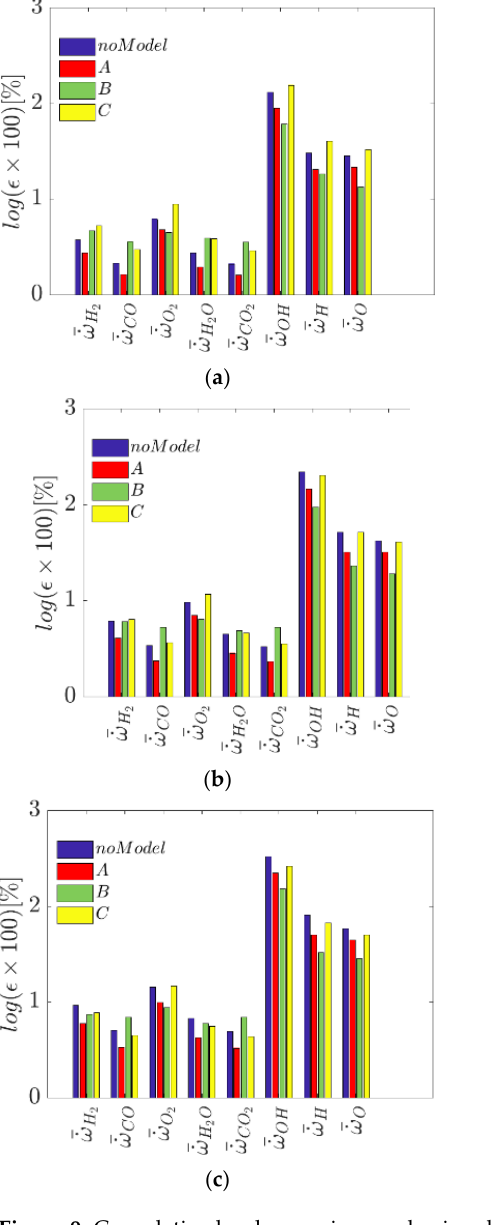
Figure 9. Cumulative local errors incurred using different models in prediction of different species net formation rates: ( a – c ) logarithm of errors for all models; and ( d – f ) the errors are divided by the “no model” approach error. Different filter widths are applied: ( a , d ) ∆ / ∆ DNS = 8; ( b , e ) ∆ / ∆ DNS = 12; and ( c , f ) ∆ / ∆ DNS = 18. The data are extracted at t = 35 t j